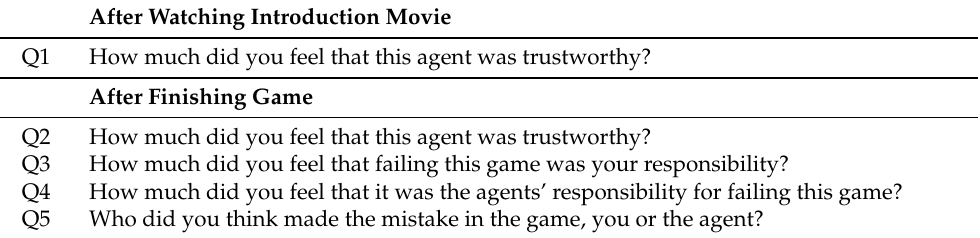
Table 3. Questionnaire in the experiment.